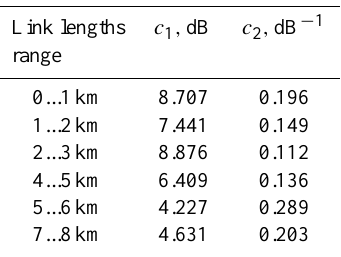
Fig. 3. Differences between total link path-averaged rainfall amount and a nearby rain gauge measurements per link-gauge pair, as a function of link length, over the entire database. 4 Table 3. Wet antenna attenuation coefficients c 1 , c 2 for various link